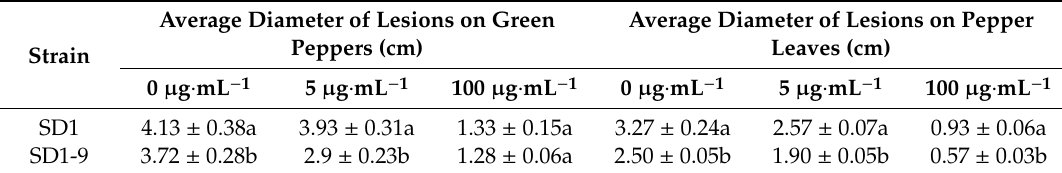
Table 2. Pathogenicity of P. capsici on green peppers and pepper leaves under di ff erent metalaxyl